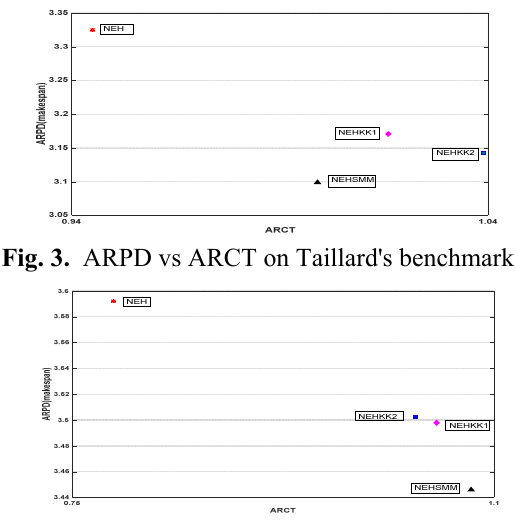
Fig. 4. ARPD vs ACPU on VRF benchmarks Fig. 5. ARPD vs ARCT on VRF